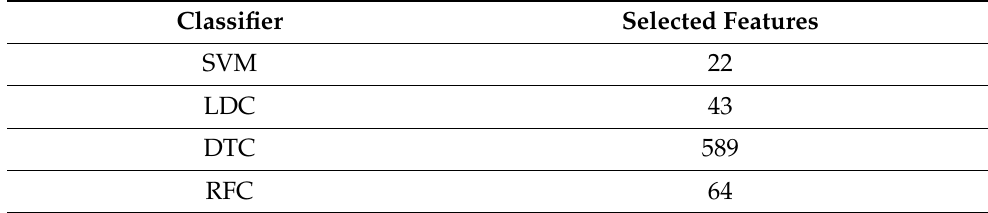
Table 4. Selection of the